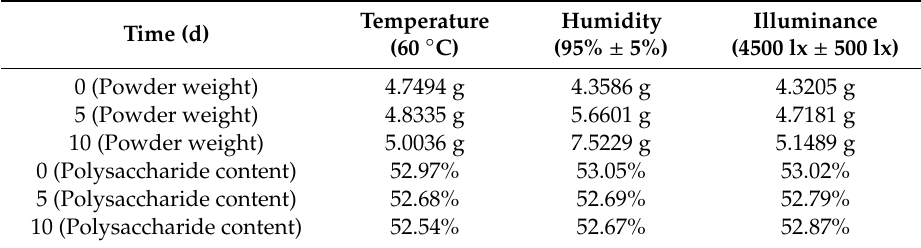
Table 3. The e ff ects of high-temperature, high-humidity and strong light exposure on the weight and polysaccharide content of BS